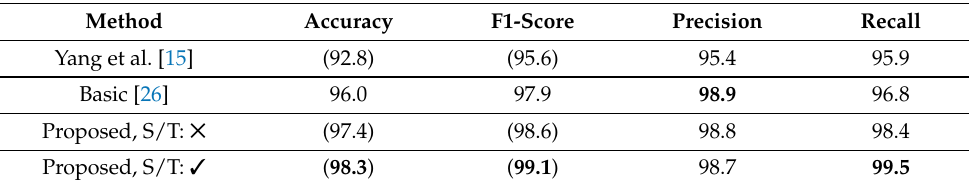
Table 3. Comparison for the social distance violation detection performance using the OxTown dataset with a 2 m social safety distance. The Yang et al. results are extracted from Table 6 in [15]. The proposed approach is compared with ( (cid:51) ) and without ( (cid:53) ) the smoothing/tracking stage (S/T). Best results are in bold to ease interpretation and results that are used in the discussion are in brackets.